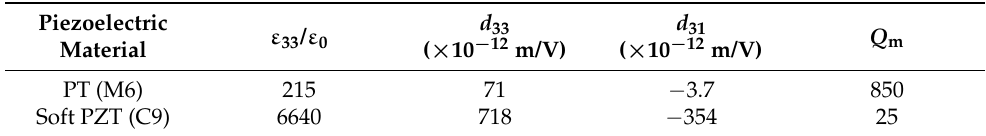
Table 1. Properties of piezoelectric materials.